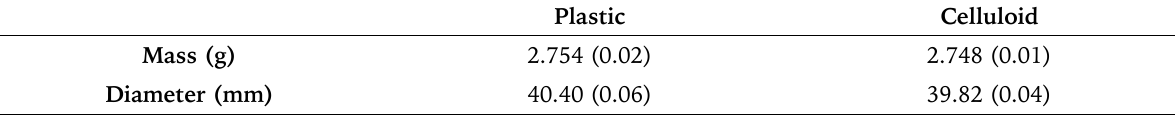
Physical properties of